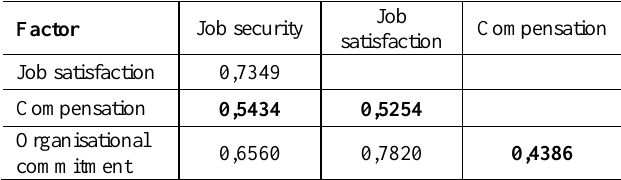
Table 4: Squared correlations between factors